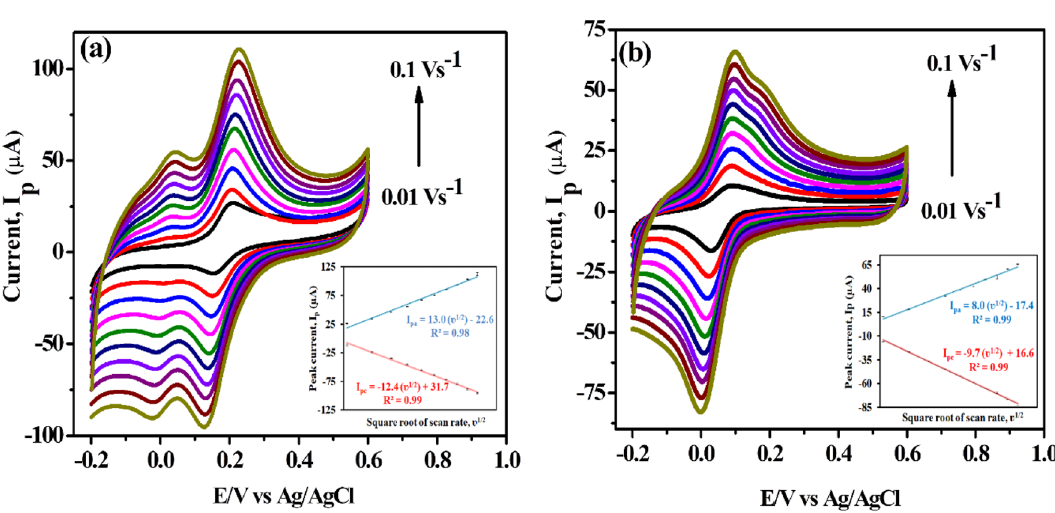
Figure 8. CV illustrating the effect of variable scan rates (0.01–0.1 Vs −1 ) on ( a ) 500 µM catechol and ( b ) 500 µM hydroquinone in 0.1 M PBS at CNCs/Zn-TPP/GCE electrode; Insets: Calibration plot of I p(a,c) vs. square root of scan rate ( ʋ 1/2 ) for CC and